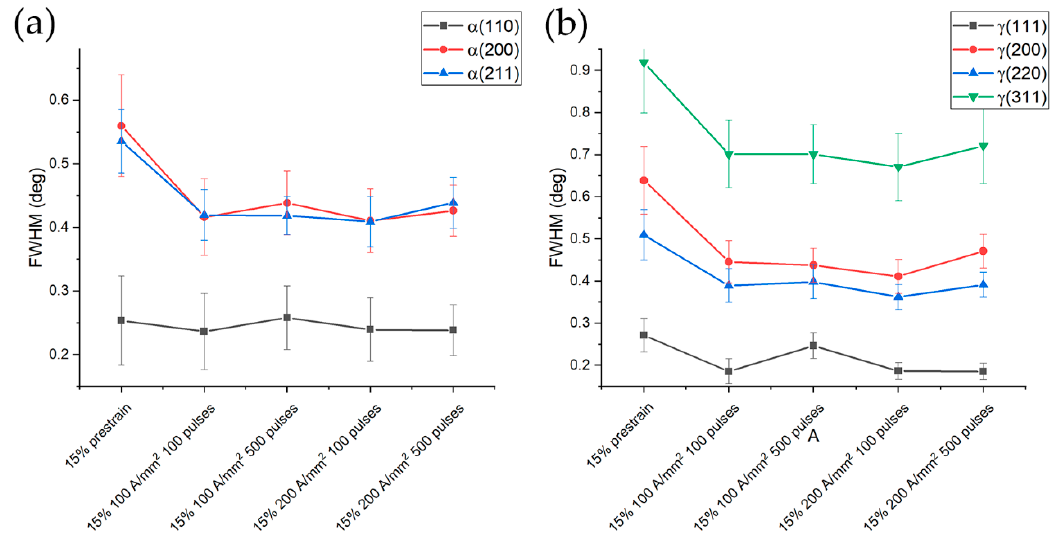
Figure 20. FWHM evolution of ferrite ( a ) and austenite ( b ) for the specimens prestrained at 15% and electropulsed.